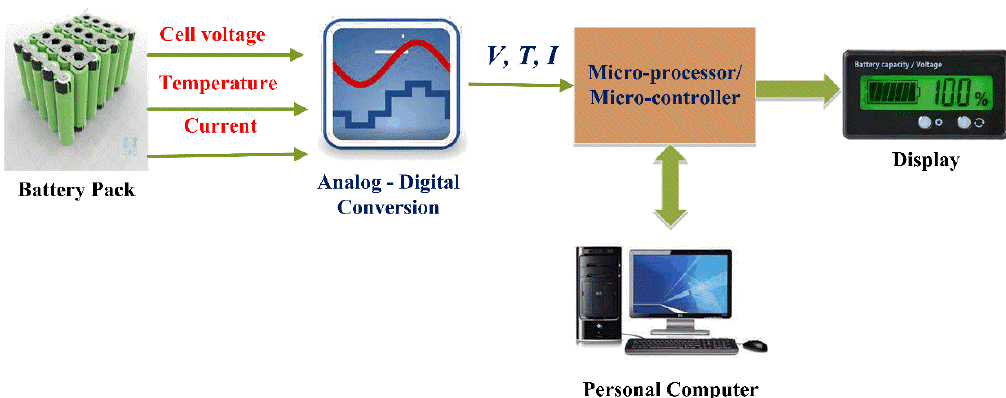
Figure 6. The general architecture of the SOC system.